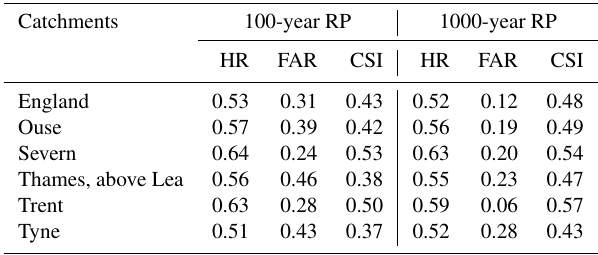
Table 4. Validation indices in England and in major river